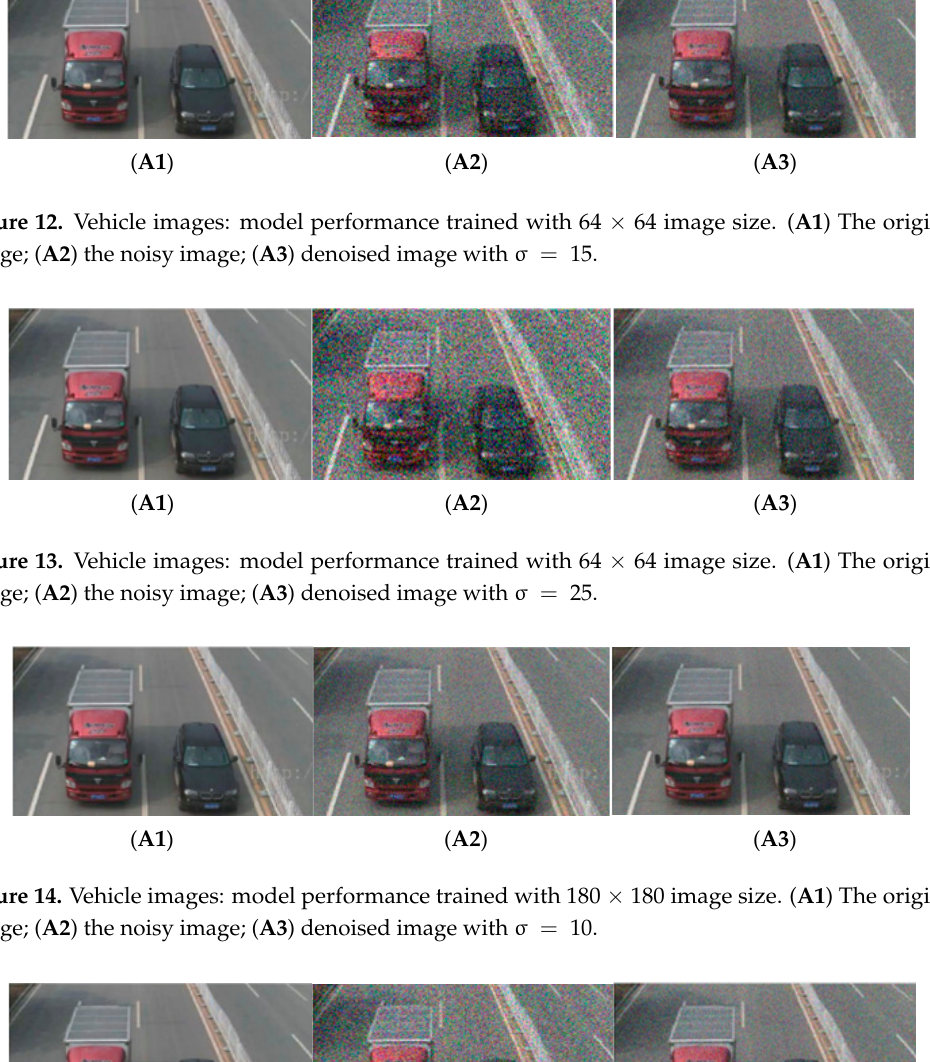
Figure 11. Vehicle images: model performance trained with 64 × 64 image size. ( A1 ) The original image; ( A2 ) the noisy image; ( A3 ) denoised image with σ = 10 .